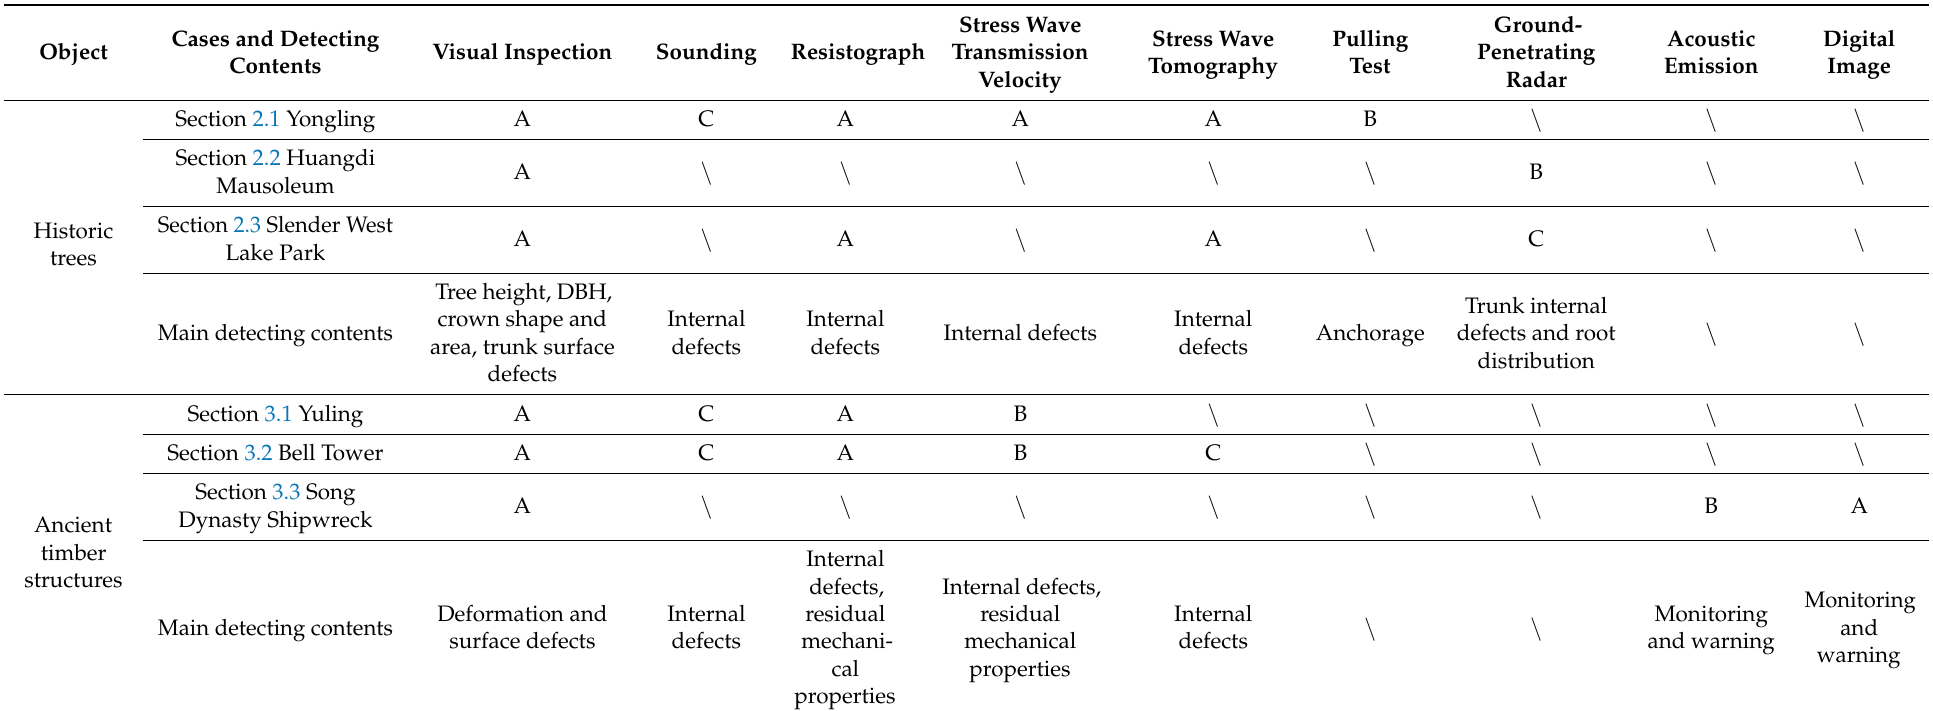
Table 1. Nondestructive testing (NDT) application list and